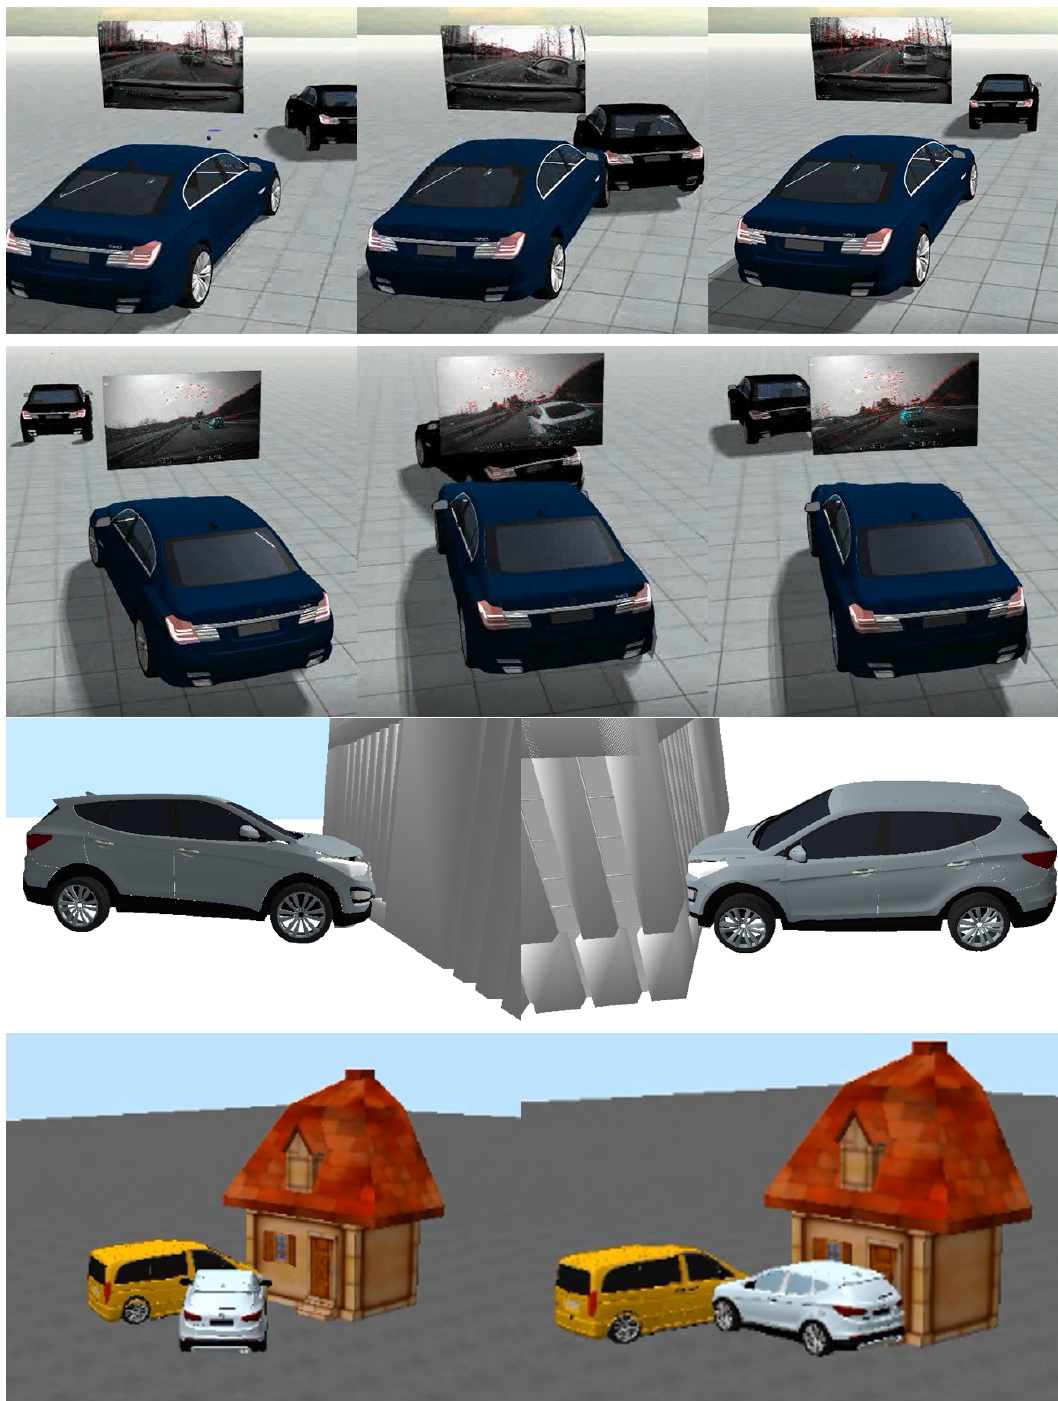
Figure 15. Various crash